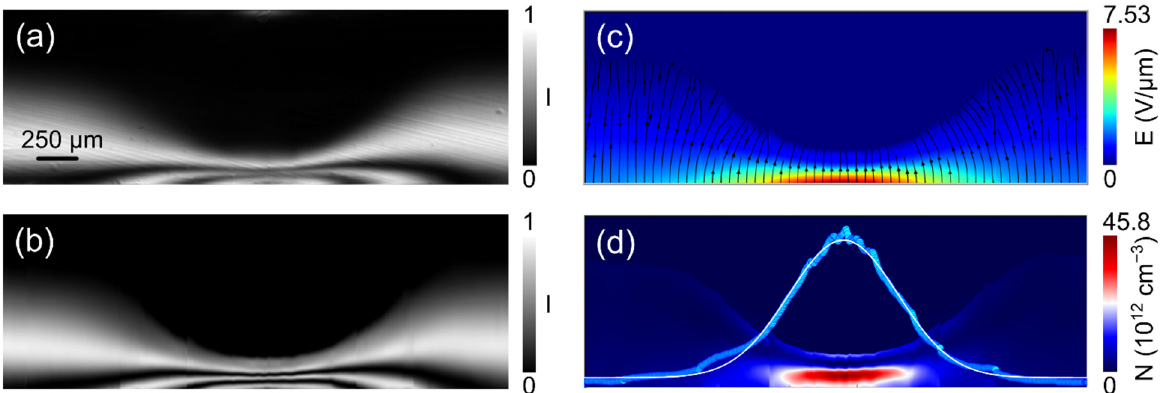
Figure 5. Electro-optic imaging and field retrieval: ( a ) the experimental normalized image, ( b ) the image obtained in the fit procedure, ( c ) the associated electric field map with streamlines indicating its local direction, and ( d ) associated space charge map with its profile (blue dots) along a horizontal crosscut passing through the maximum, at around 70 μ m from the bottom anode. The white solid line is a Gaussian fit of the retrieved charge profile.